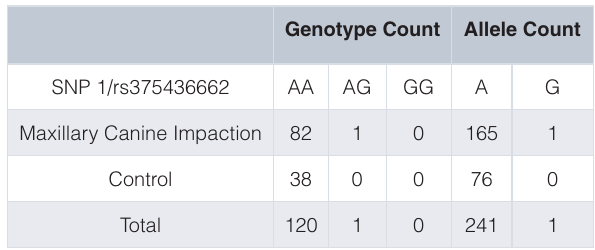
Table 6. Genotype analysis of SNP 3 in case and control samples.